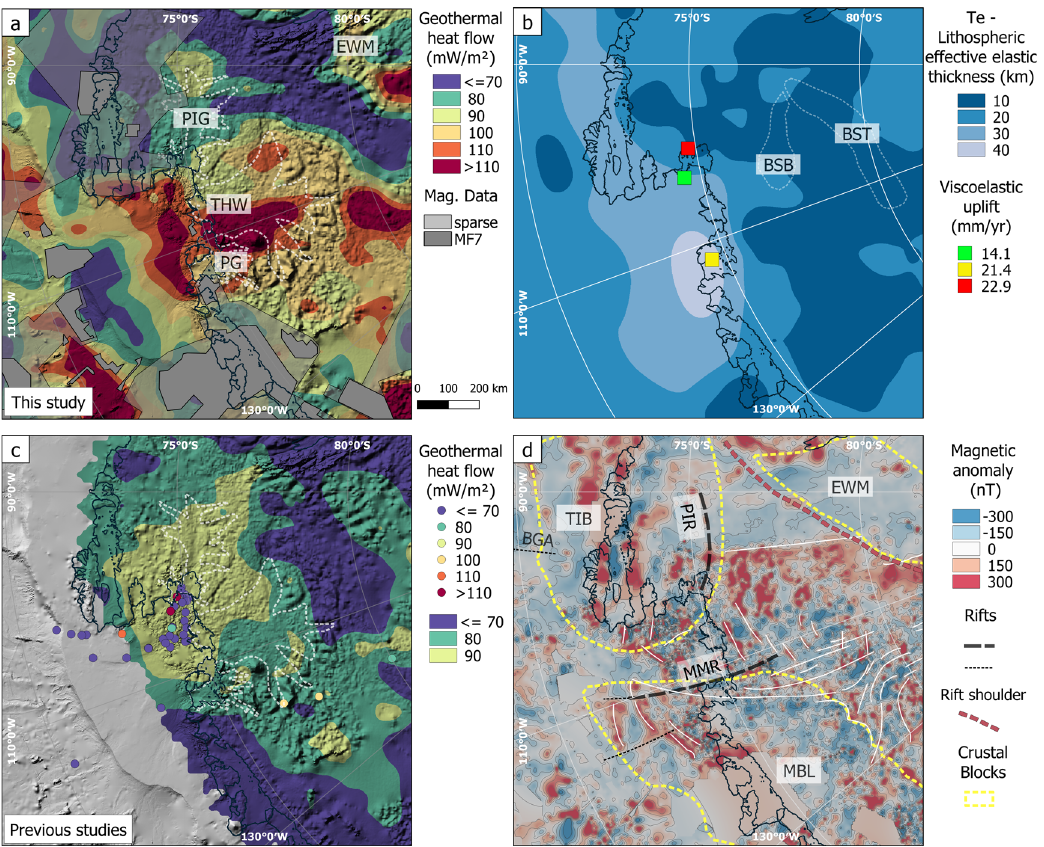
Fig. 3 Geothermal heat fl ow, lithospheric elastic thickness and magnetic anomaly distribution of the Amundsen Sea sector. a Geothermal heat fl ow distribution with areas of magnetic data gaps and those with MF7 magnetic data coverage (https://www.geomag.us/models/MF7.html) shown in gray. White dashed lines mark location of glaciers: PIG Pine Island glacier, THW Thwaites glacier, PG Pope glacier. b Lithospheric effective elastic thickness 29 and the visco-elastic response 32 . White dashed lines show area of Byrd subglacial basin (BSB) and Bentley subglacial trough (BST). c Compilation of continental-wide 6 and local in-situ estimates of geothermal heat fl ow 15,16,34,35 . d Tectonic features of the study region. The high geothermal heat fl ow region (A) is surrounded by the Thurston Island Block (TIB), Ellsworth – Whitmore Mountain (EWM) block and Marie Byrd Land (MBL). The Mount Murphy Rift (MMR) 54 correlates with a suite of NNE – SSW trending magnetic lineaments (marked with white lines). The Pine Island rift (PIR) is shown as part of the Thurston Island